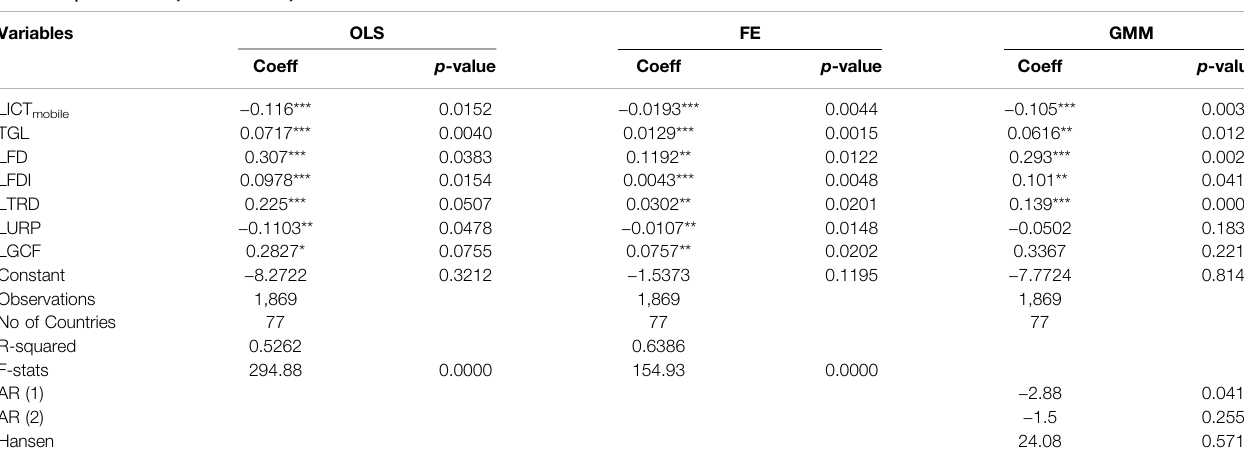
TABLE 5 | Static and dynamic elasticity evidence. Variables